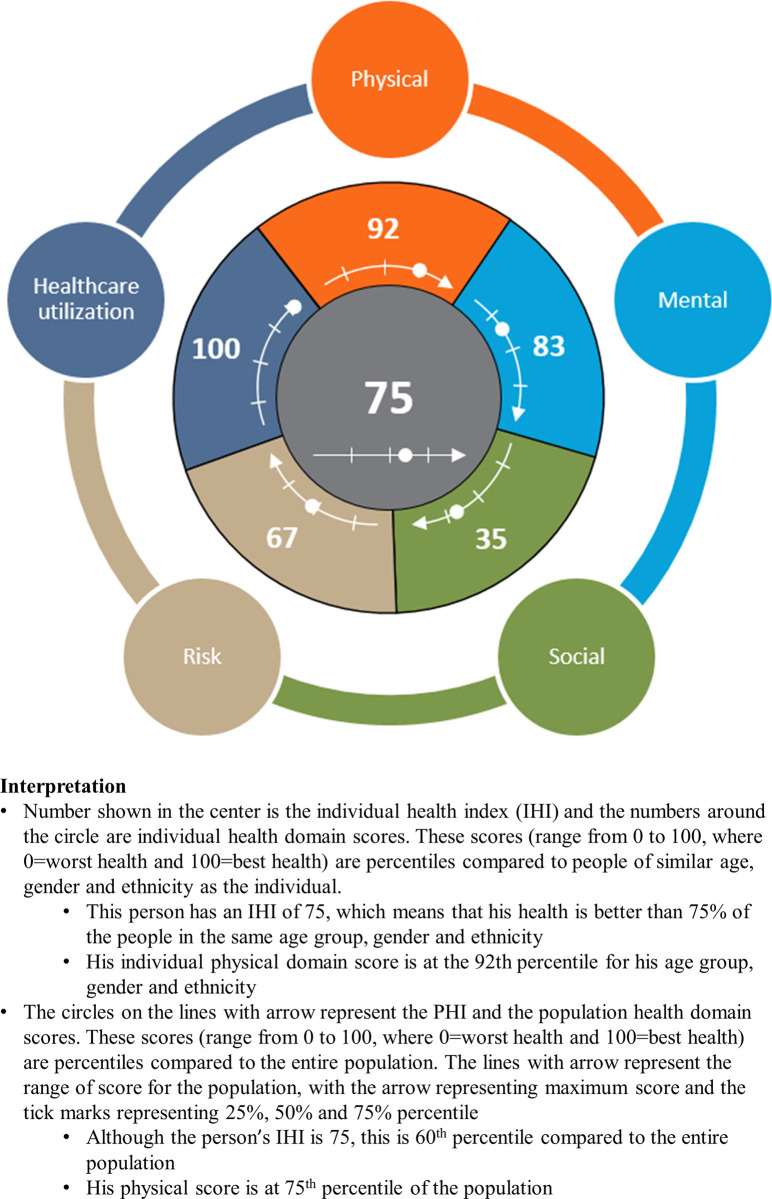
Badge for the IHI, PHI and domain scores for an individual.